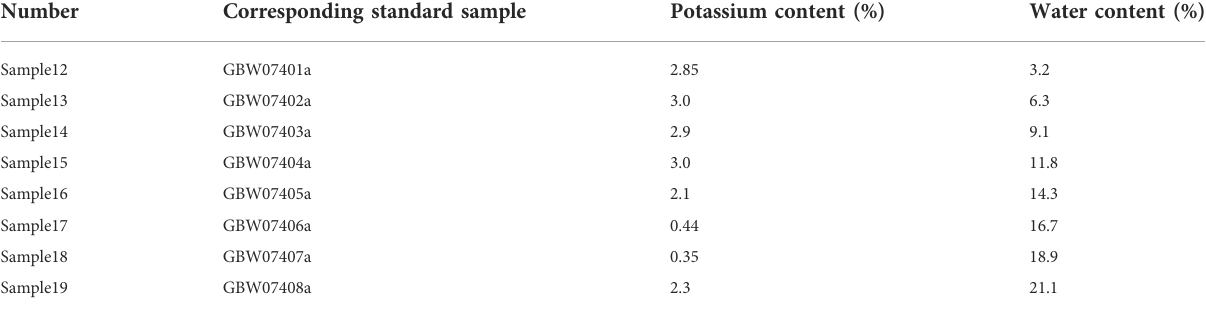
TABLE 4 Relevant characteristics of the third group of tablet